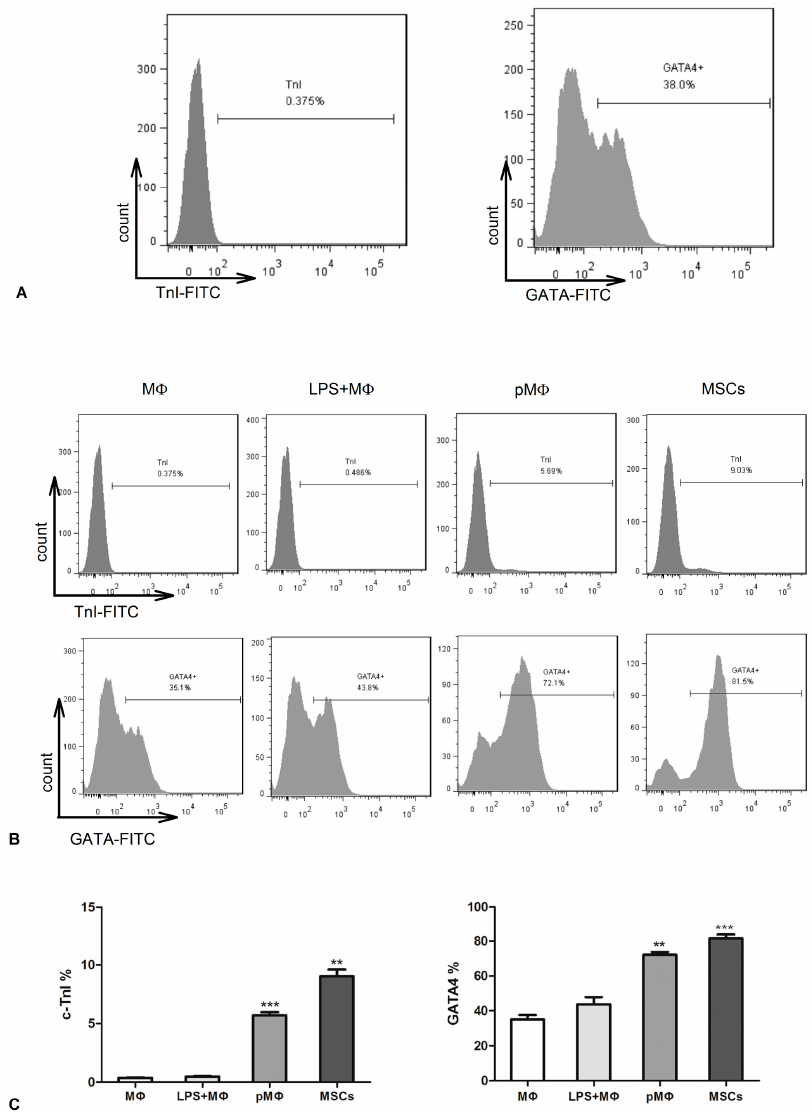
Figure 5. The markers of cardiomyocytes were detected in CSCs. ( A ) CSCs were obtained from the hearts of mice and then GATA-4 and TnI were detected by FCM; ( B , C ) CSCs co-cultured with the supernatants of M Φ , LPS-M Φ , pM Φ , and MSCs were harvested after 7 days. FCM was used to detect cardiomyocytes markers. GATA-4 and TnI showed significantly higher expression in the pM Φ and MSC groups; ** p < 0.01; and *** p < 0.001, compared with M Φ . The percentage and the bar of each group represent the mean value of triplicate results, which means that three independent experiments were done.